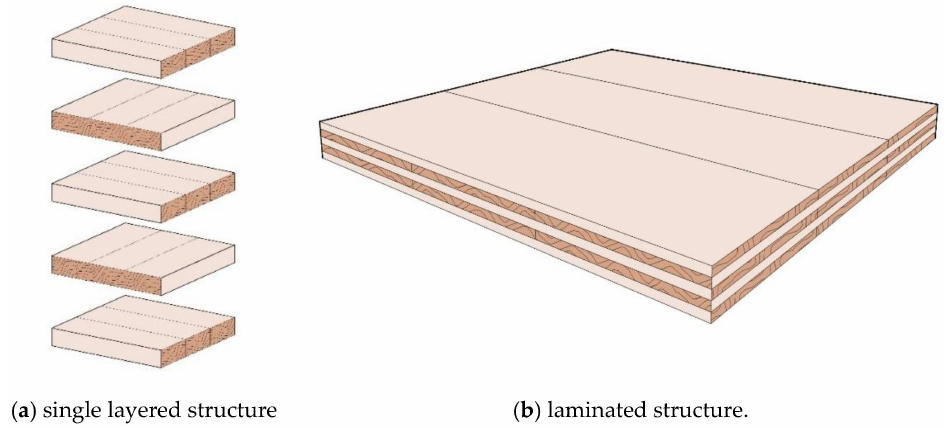
Figure 1. Cross-laminated timber (CLT) construction in five